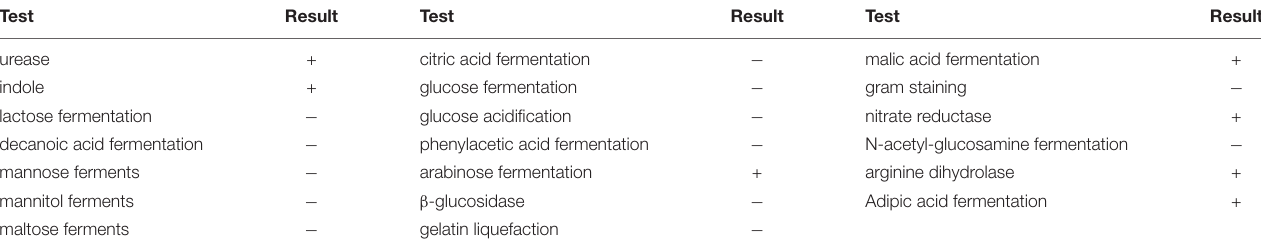
TABLE 1 | Physiological and biochemical characteristics of strain Phe15.